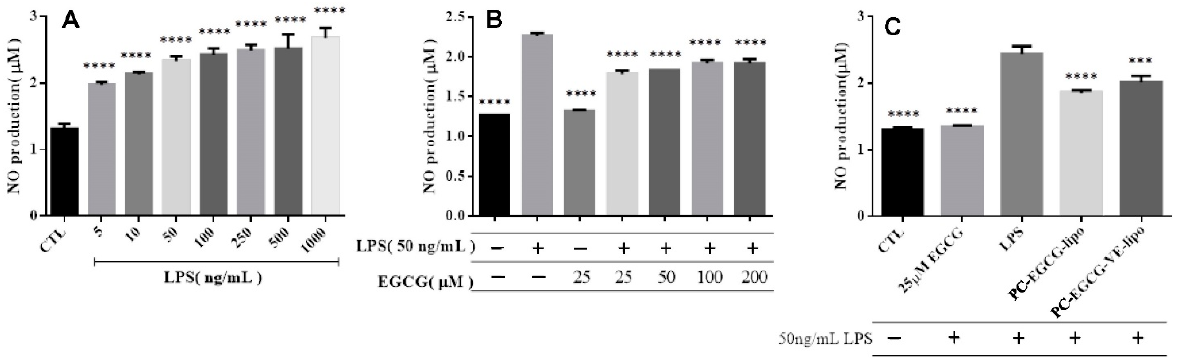
Figure 3. Nitric oxide (NO) production from BV-2 cells (*** p < 0.001; **** p < 0.0001, n = 3). ( A ) Inflammation induced by various concentration of LPS (compared with control group), ( B ) cells treated with EGCG followed by LPS induction (compared with LPS (+) and EGCG ( − )), ( C ) cells treated with EGCG, PC-EGCG-liposomes, and EGCG-VE-liposomes then LPS (compared with LPS (+)).